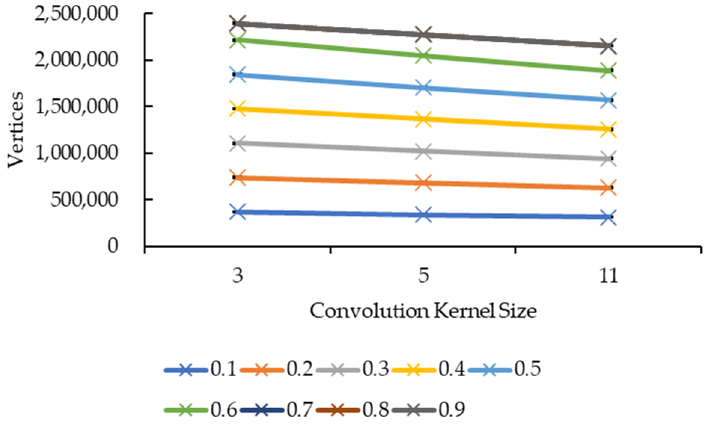
Figure 15. Graph of number of vertices against convolution kernel size.